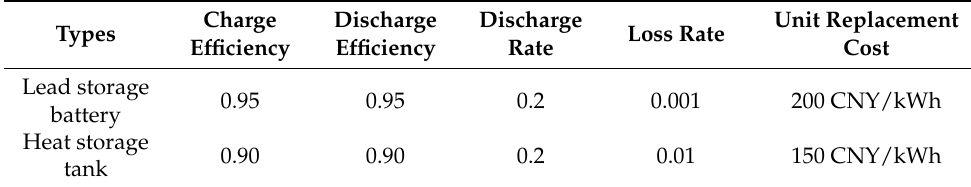
Table 2. Parameters of ES and